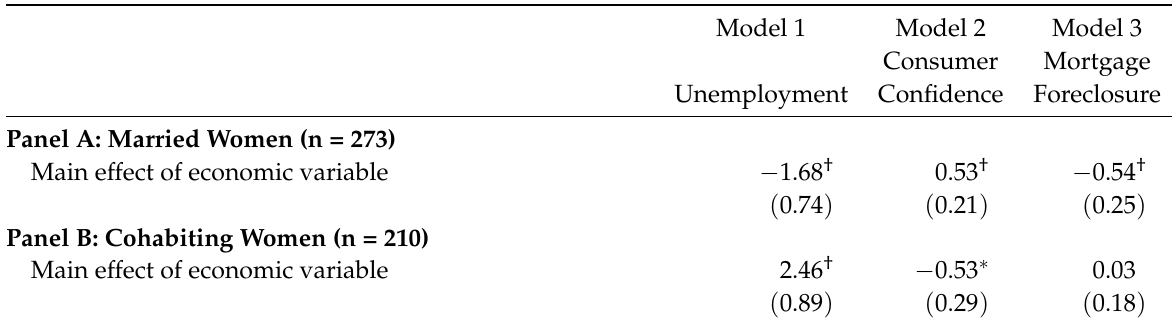
Table 5: Coefficients from logit models predicting intended pregnancy by local economic conditions for women without a previous